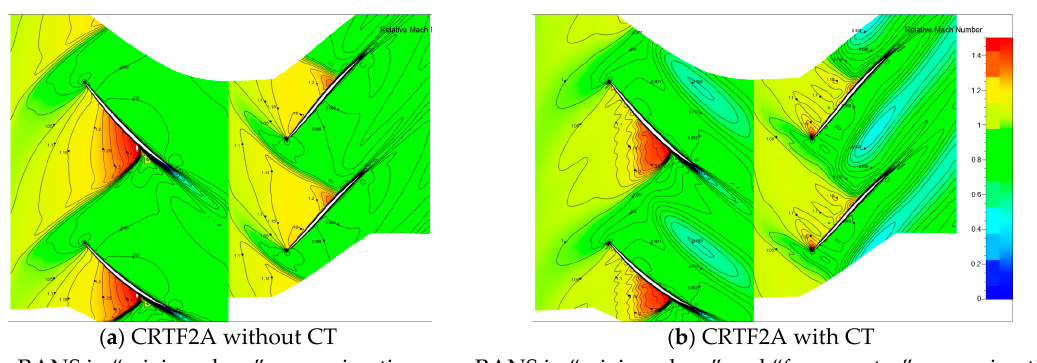
Figure 32. Comparison of Mach numbers for a smooth flowpath and with CT. Operating line. n = 100%. Section 0.95 h. ( a ) CRTF2A without CT; ( b ) CRTF2A with CT.